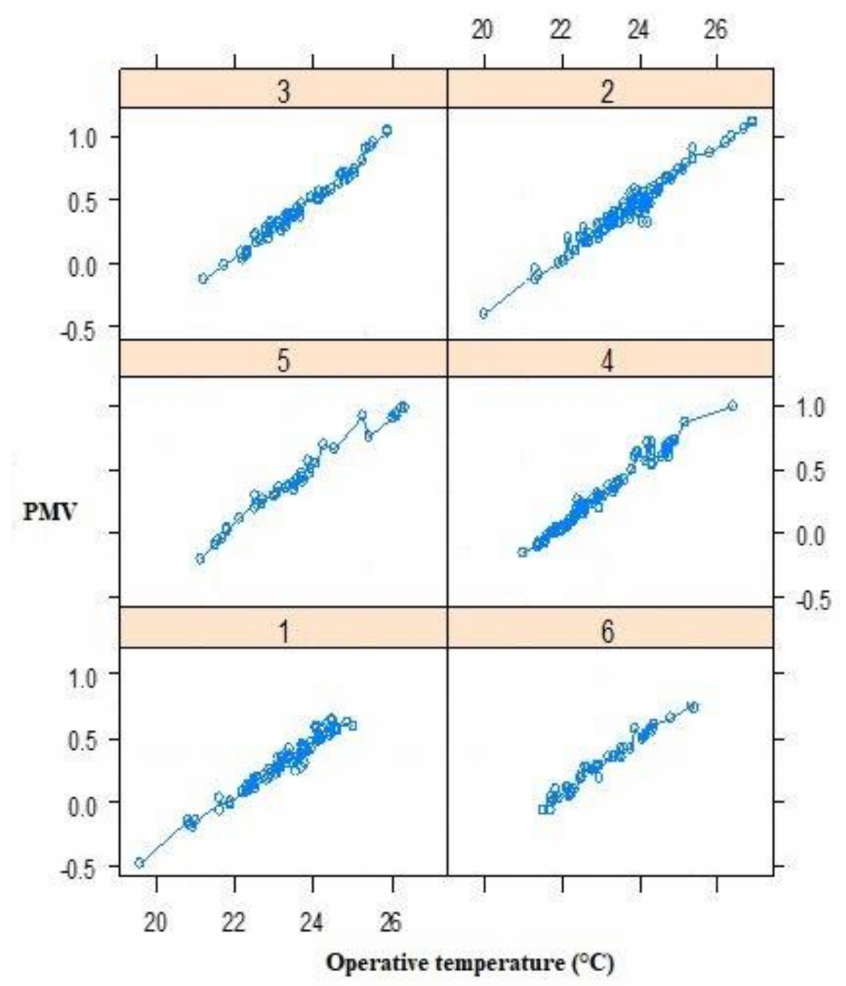
Figure 16. Predicted mean vote (PMV) versus operative temperature in each building. For i = (1 . . . n) and j = (1 . . . m), linear mixed models were described as